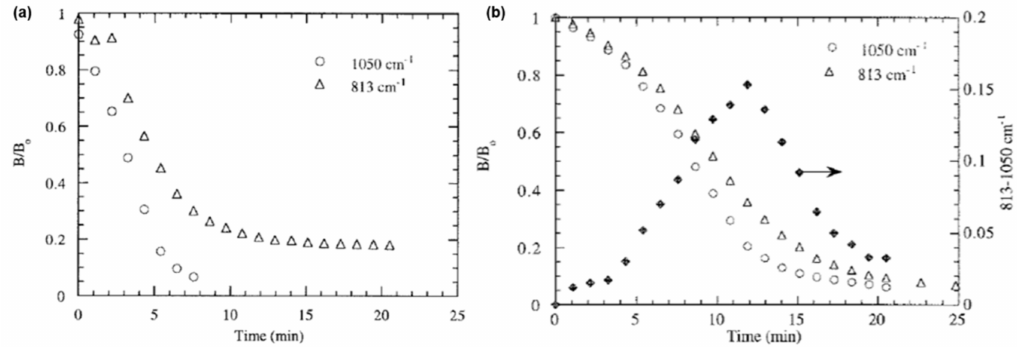
Figure 37. ( a ) Conversion of benzoxazine monomer ( p C − ma) with ( a ) 10 mol% p C and ( b ) 9 mol% sebacic acid at 160 ◦ C [256]. Copyright 1999. Reproduced with permission from John Wiley & Sons,